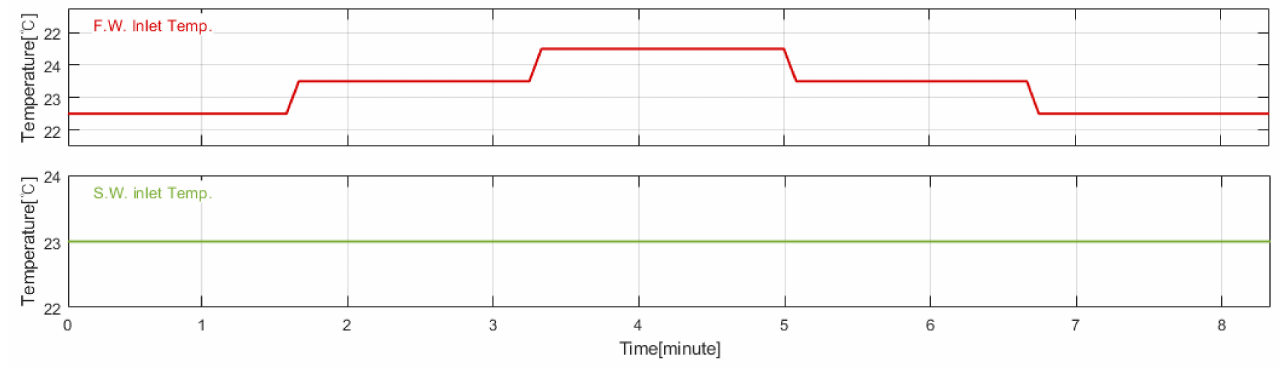
Figure 16. Input signals.